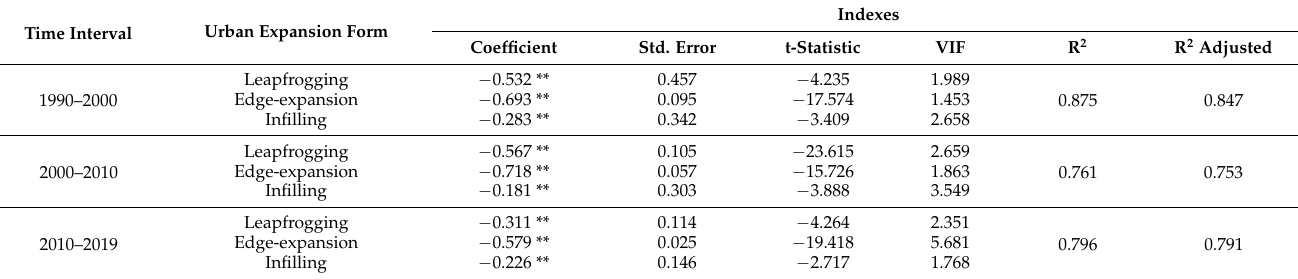
Table 7. The variance analysis results of the MLR model for the expansion intensity of urban expansion forms and the change in FS in different time